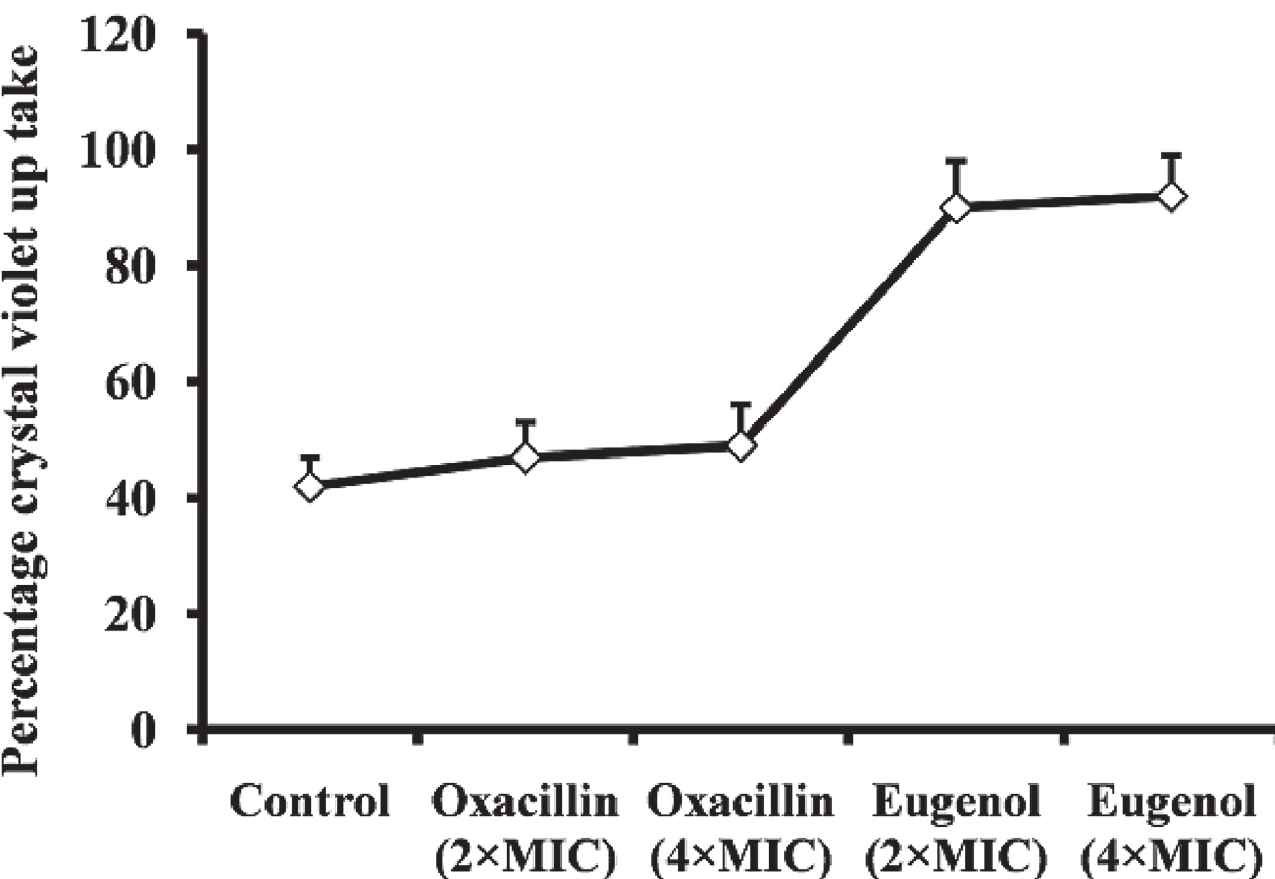
Fig 7. Crystal violet uptake of eugenol and oxacillin-treated S. aureus (ATCC 29213). The bacteria were treated with 2×and 4×MIC of eugenol or oxacillin and crystal violet absorption was assayed as show in the methods section. The mean ± SD for three replicates are